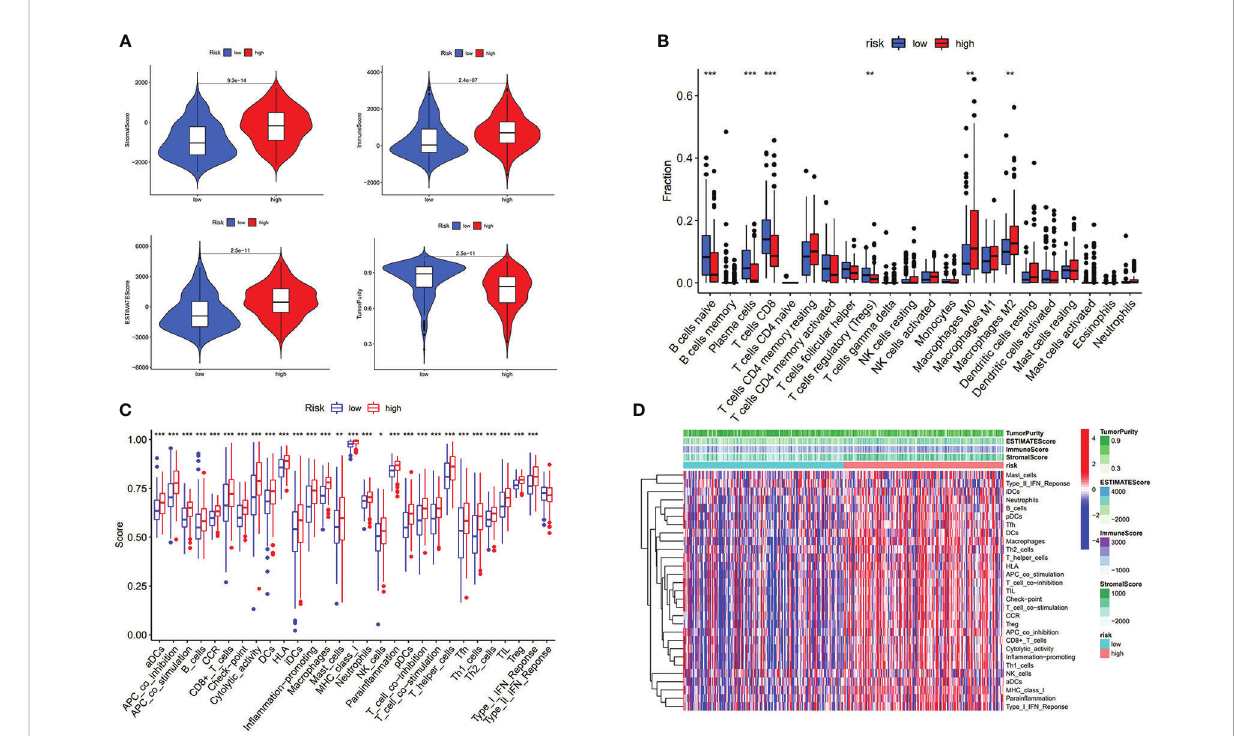
FIGURE 4 Risk score associated with immunological features. (A) Comparison of stromal score, immune score, estimate score, and tumor purity between low-risk group and high-risk group. (B) Comparison of immune cells is displayed in boxplot. (C) Score of immune-related pathway. (D) Heatmap of immune features of two subgroups. * p < 0.05, **p < 0.01, ***p <